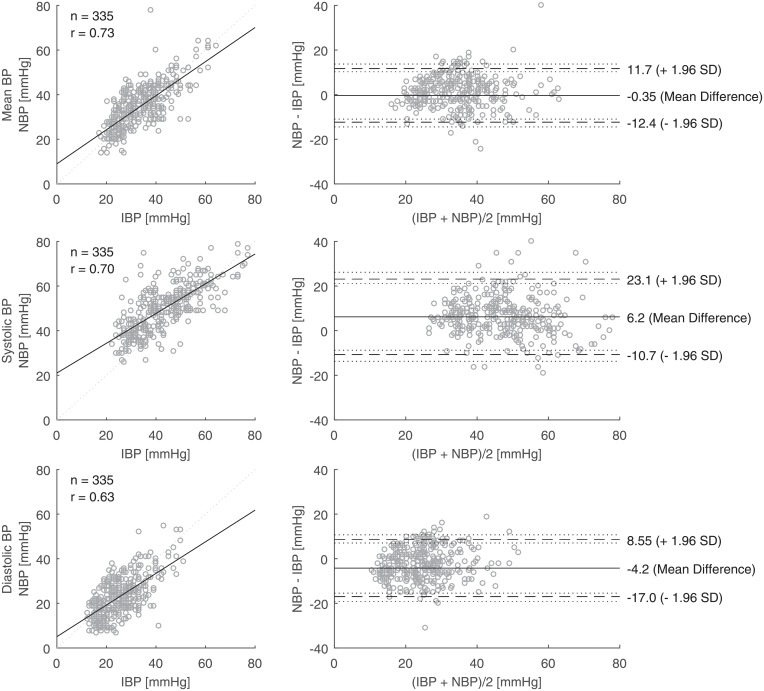
Linear regressions (left; dotted line: Line of equality; r: Pearson correlation coefficient) and Bland-Altman plots (right; dashed lines: Limits of agreement; dotted lines: Confidence intervals) for pairs (n = 335) of invasively (IBP) and non-invasively measured blood pressure (NBP) readings in the first four weeks of life obtained from preterm infants born below 28 weeks of gestation.